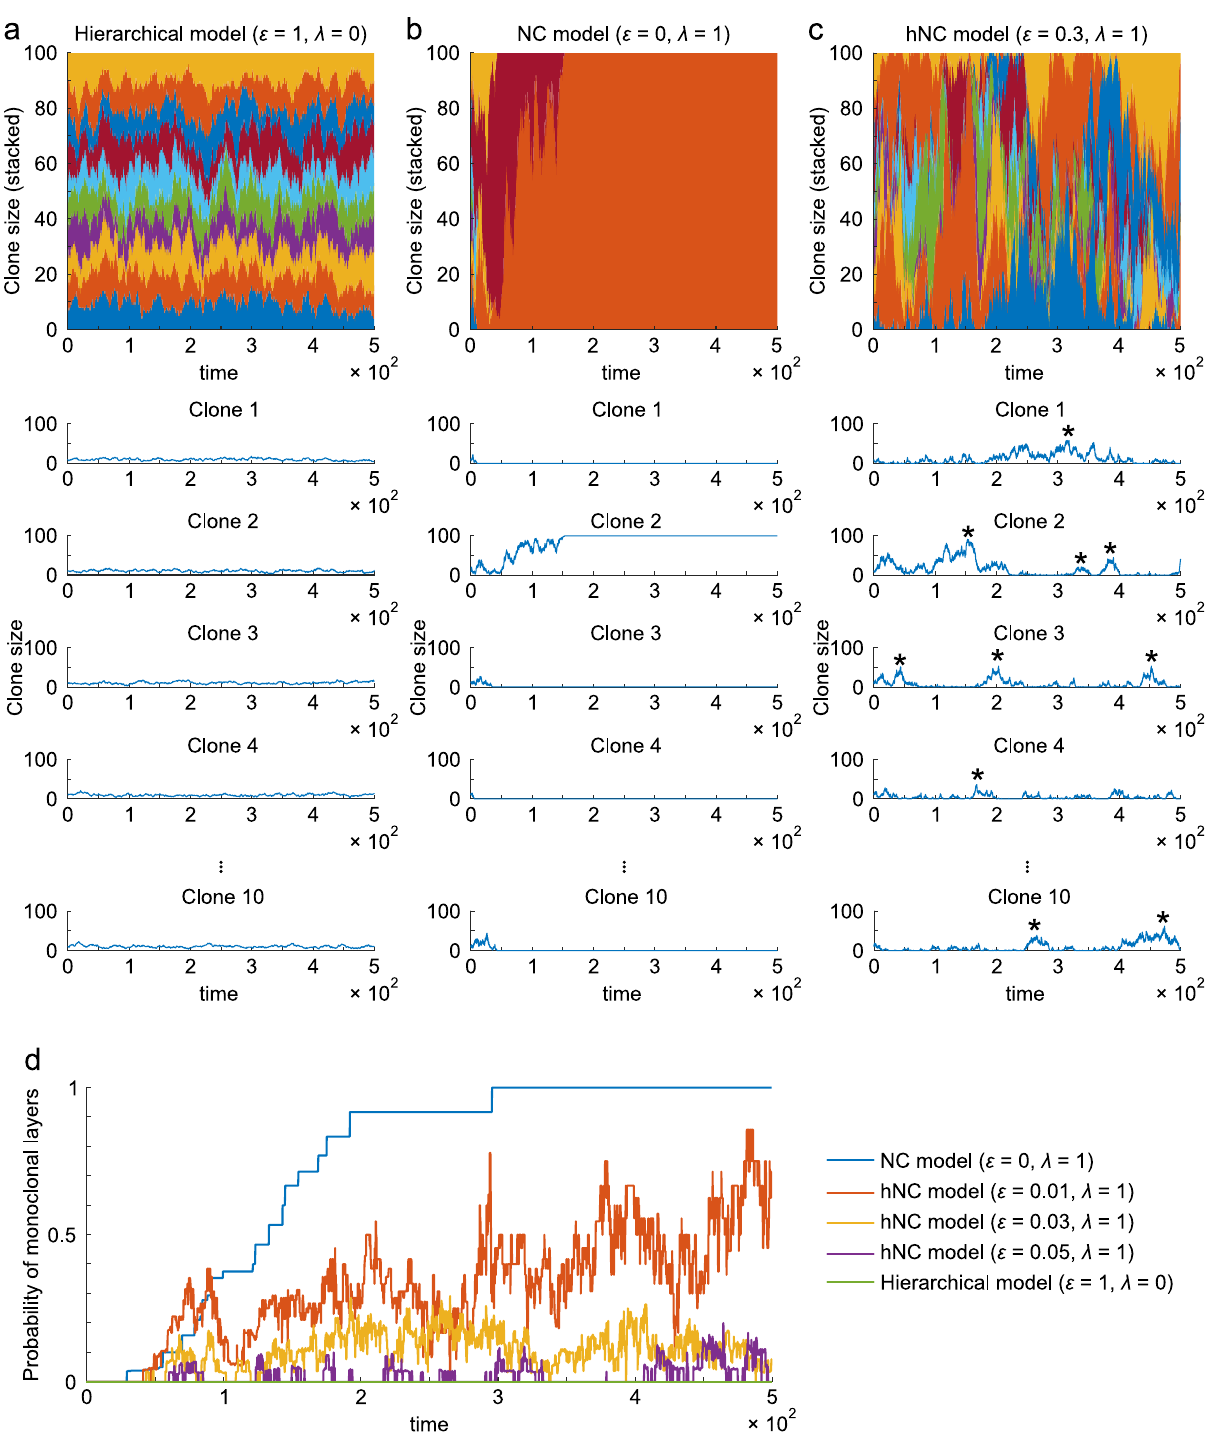
Fig. 2 Clonal expansion in the hierarchical, NC, and hNC model. a – c Time-series of clone sizes with different proliferation rates of master stem cells ( ε ) and competitive stem cells ( λ ). In the simulation, there were 10 types of clones in 100 competitive stem cells in the open layer, in which the clone size of every clone was initially uniform, i.e., n k ¼ 10 at t = 0. Asterisks indicate representative bursts. In the top panels, the fraction of each clone is displayed by a different color. In the lower panels, the results of fi ve representative clones within 10 clones are displayed. d The probability of monoclonal conversion in open layers over time. We repeated simulations 1000 times, and the probability that the open layer became monoclonal at each timepoint is cells from the closed layer (Fig. 2a). In contrast, in the NC model repeated expansion and contraction, like the bursts (Fig. 2c). ( ε = 0, λ > 0), only one clone dominated the open layer, and all These clonal bursts were generated by the mechanism that each other clones were extinguished through neutral, random drift of clone was headed to domination or extinction by neutral drift; clonal populations (Fig. 2b). Interestingly, in the hNC model (0 < ε ≤ λ ), each clone population showed intermittent and